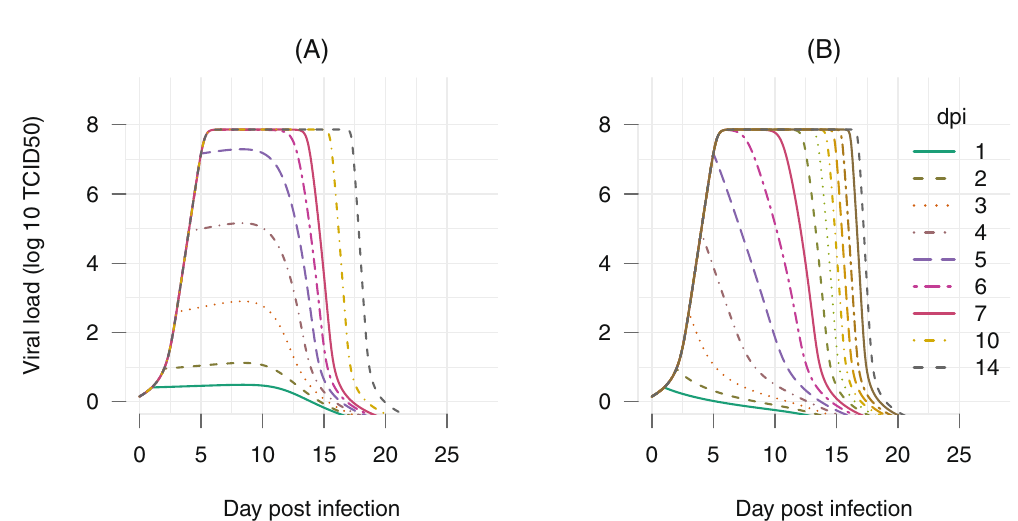
Figure 6. Simulation of single-dose mAbs treatment assuming a long mAbs half-life of 28 days. The time administrated mAbs were varied from 1 to 14 days. For each regimen, the model of viral dynamic including both treatment and IgG effects were simulated to generate the corresponding viral load dynamics. ( A ) assuming a low effect ( K m = 0.98), the general IgG profile with the working threshold K Ab = 10 4.5 , and a long half-life mAbs of 28 days; ( B ) assuming a high effect ( K m = 1.47), the general IgG profile with the working threshold K Ab = 10 4.5